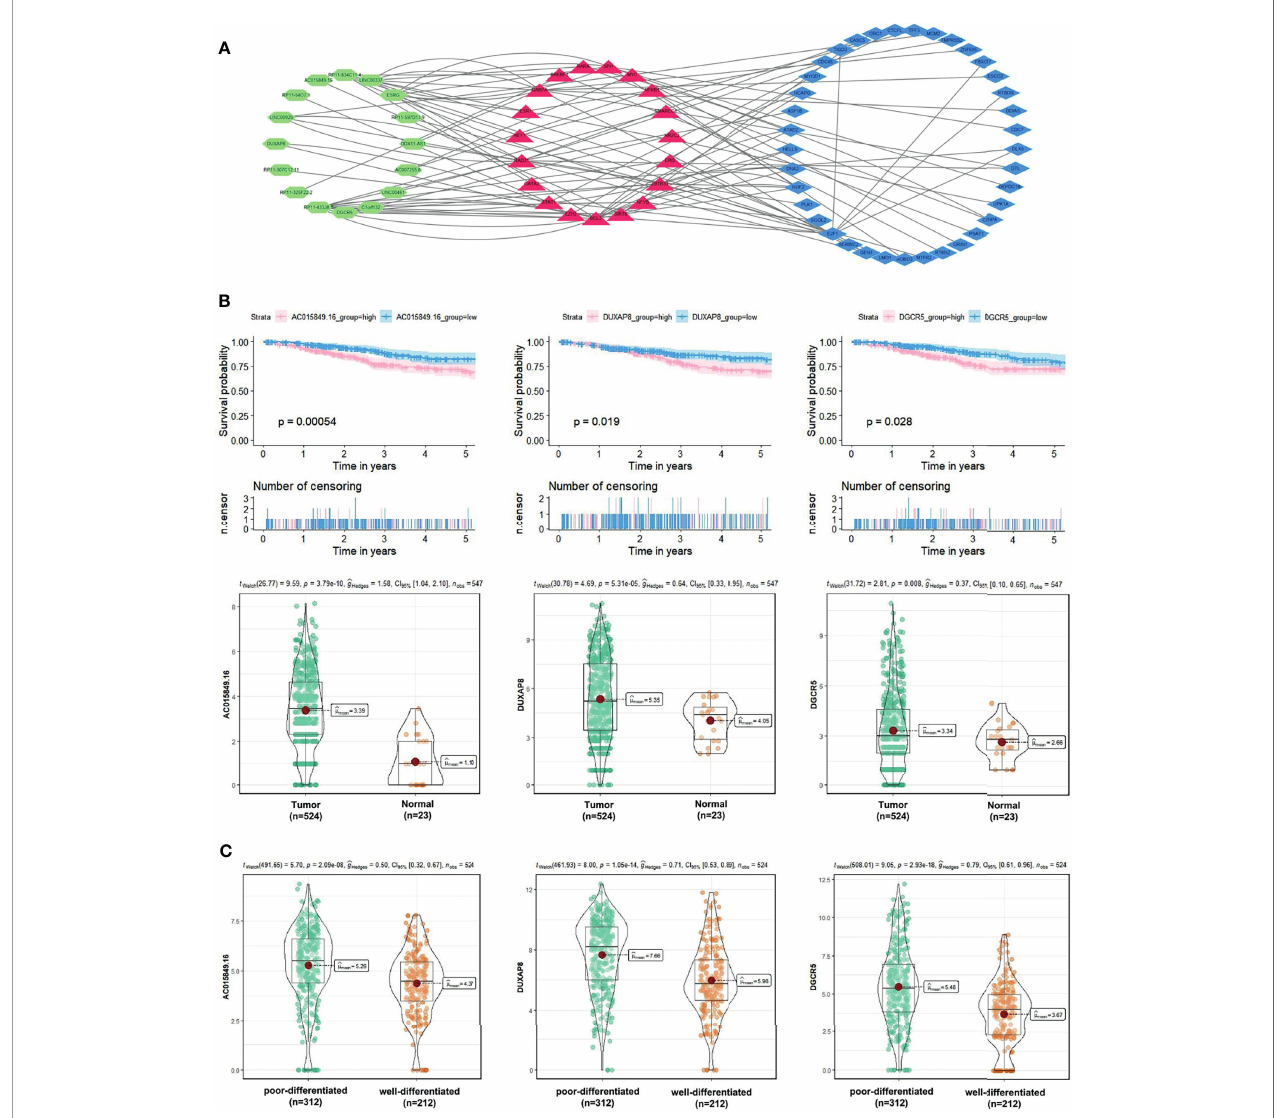
FIGURE 9 | Exploration of the molecular mechanism of UCEC-related lncRNA in the Blue and Brown modules. (A) Construction of lncRNA-transcription factor (TF)- mRNA networks. (B) 3 lncRNA strands (AC015849.16, DUXAP8 and DGCR5) were signi fi cantly negatively related to the 5-year OS of patients with UCEC, with higher expression levels in UCEC tissues compared to non-tumorous tissues. (C) The expression levels of AC015849.16, DUXAP8 and DGCR5 between poorly and well-differentiated UCEC tissues in the TCGA